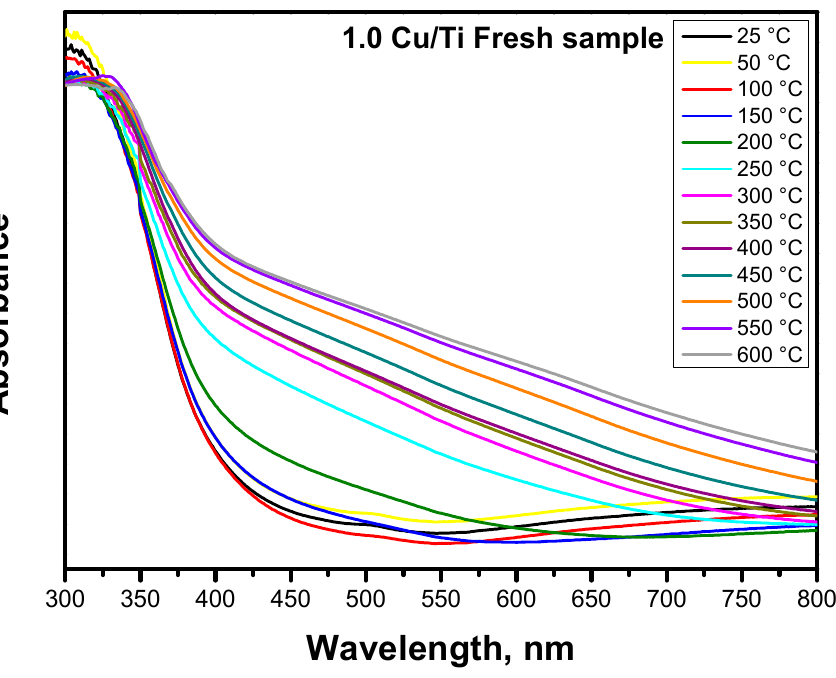
Figure 3. UV-vis -DRS collected spectra for the 1.0 Cu/Ti fresh sample with temperature increasing from 25 to 600 °C.